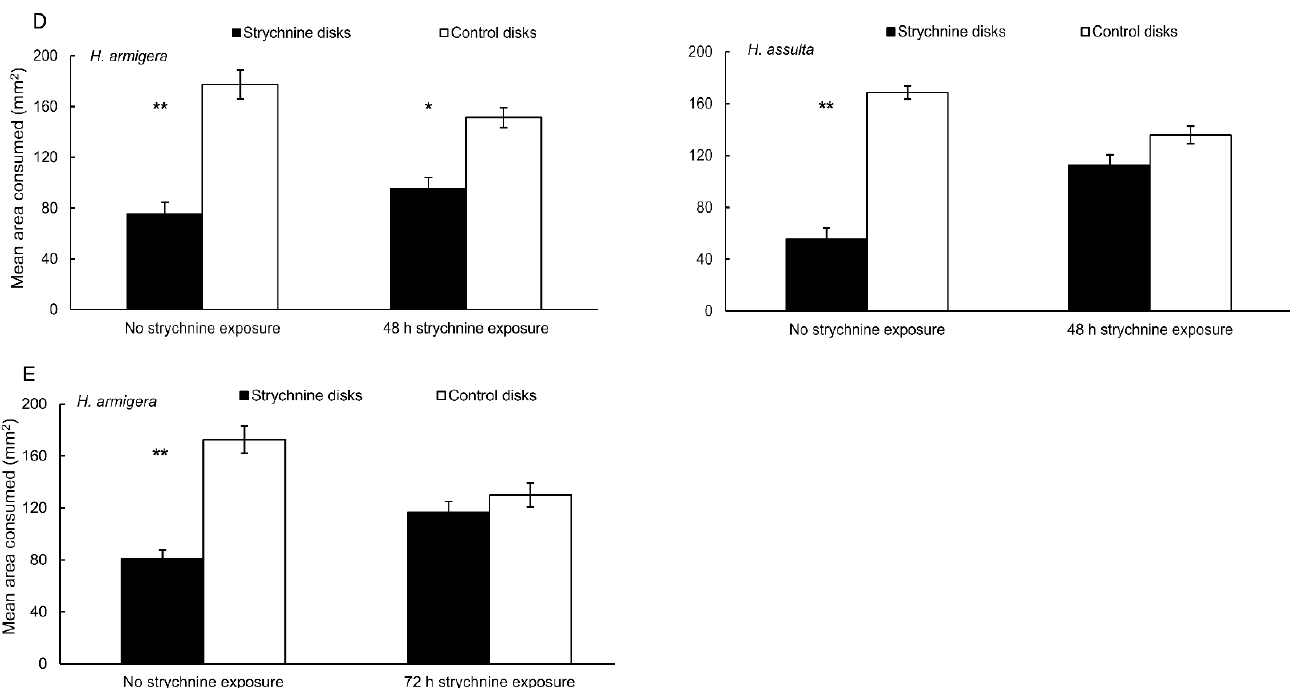
Figure 2. Feeding preference behavior of H. armigera larvae and H. assulta larvae, reared on standard artificial diet (no strychnine exposure) or artificial diet containing strychnine for different durations of dietary exposure, indicated along horizontal axis, on pepper fruit disks in choice assays between control disks and disks containing strychnine. Left lane: H. armigera larvae; right lane: H. assulta larvae. ( A ) Exposed from neonate until the molt to the 5th instar; ( B ) exposed during 24 h since the molt to the 5th instar; ( C ) exposed during 36 h since the molt to the 5th instar; ( D ) exposed during 48 h since the molt to the 5th instar; ( E ) H. armigera larvae, exposed during 72 h since the molt to the 4th instar; replicated 20 times for each assay. Vertical lines represent standard errors. Asterisks indicate significant differences between treated and control disks according to the paired-samples t -test (* p < 0.05, ** p < 0.01).